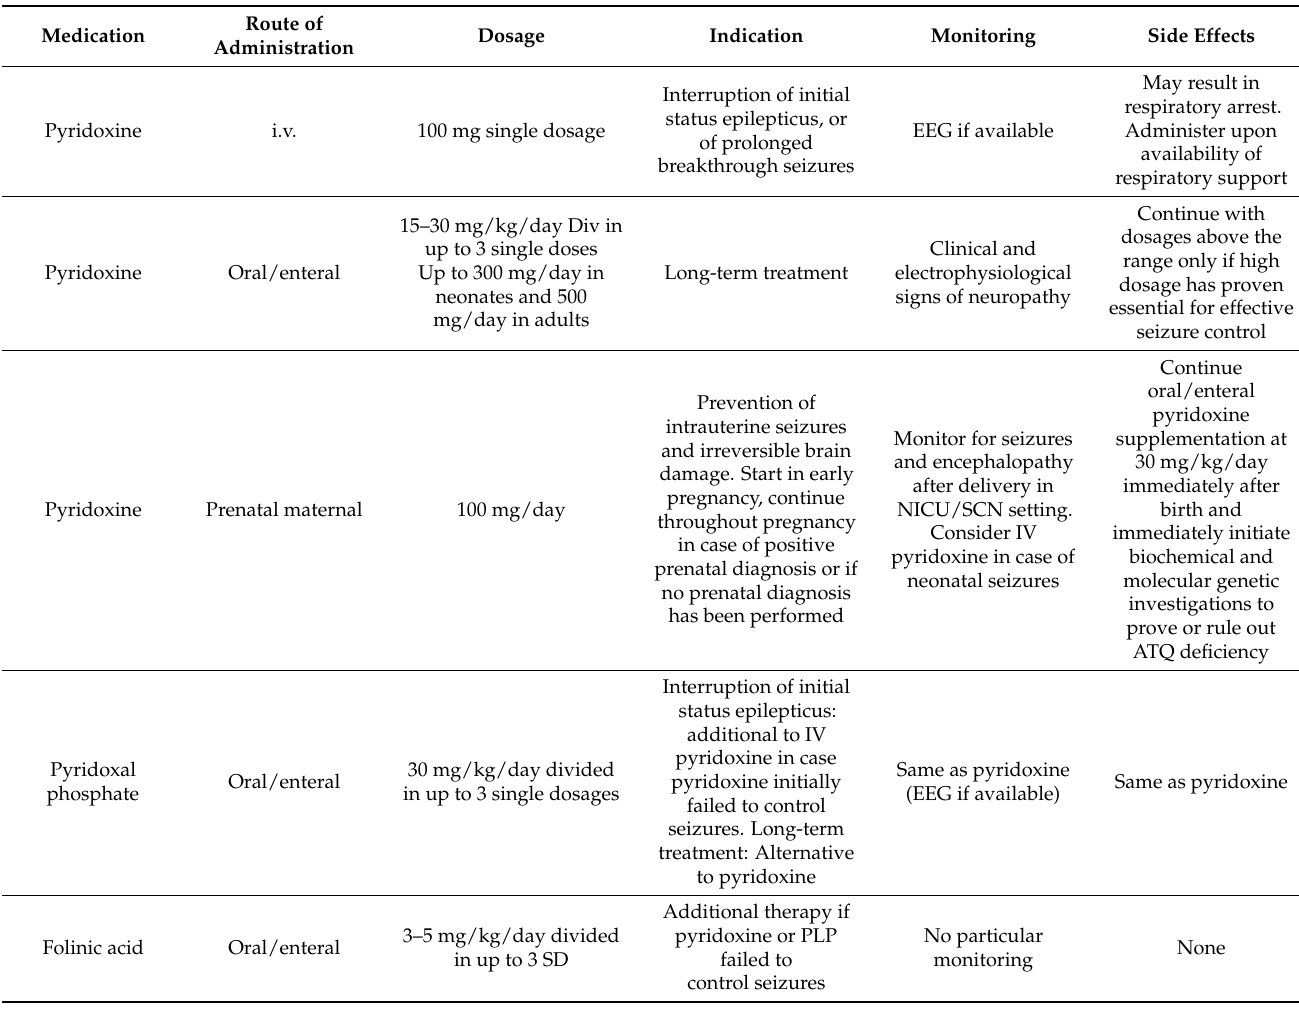
Table 3. Medications used in PDE treatment